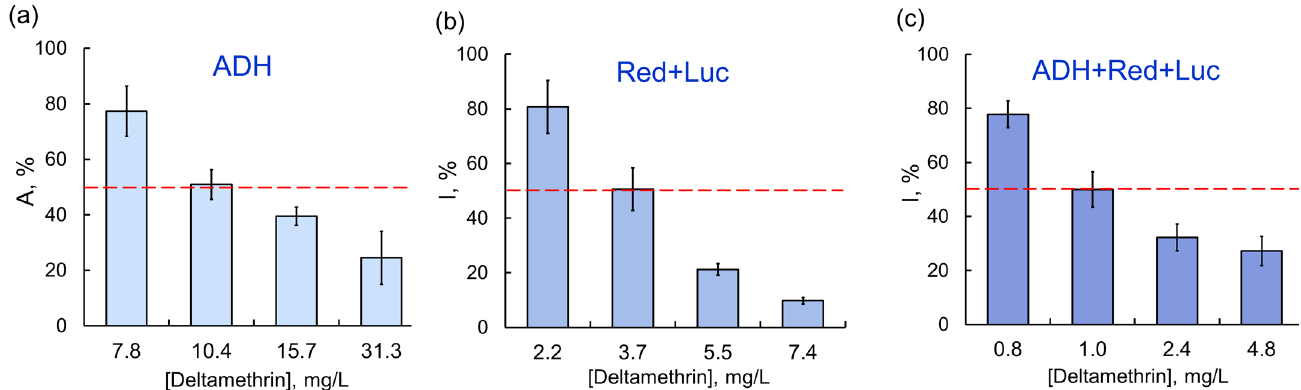
Figure 3. Relationship between residual activity of enzyme assay systems and concentration of del- tamethrin as AIa: ( a ) ADH; ( b ) Red + Luc; ( c ) ADH + Red + Luc. The inhibitory effects of deltame- thrin as AIa were enhanced by elongation of the chain of conjugated enzyme